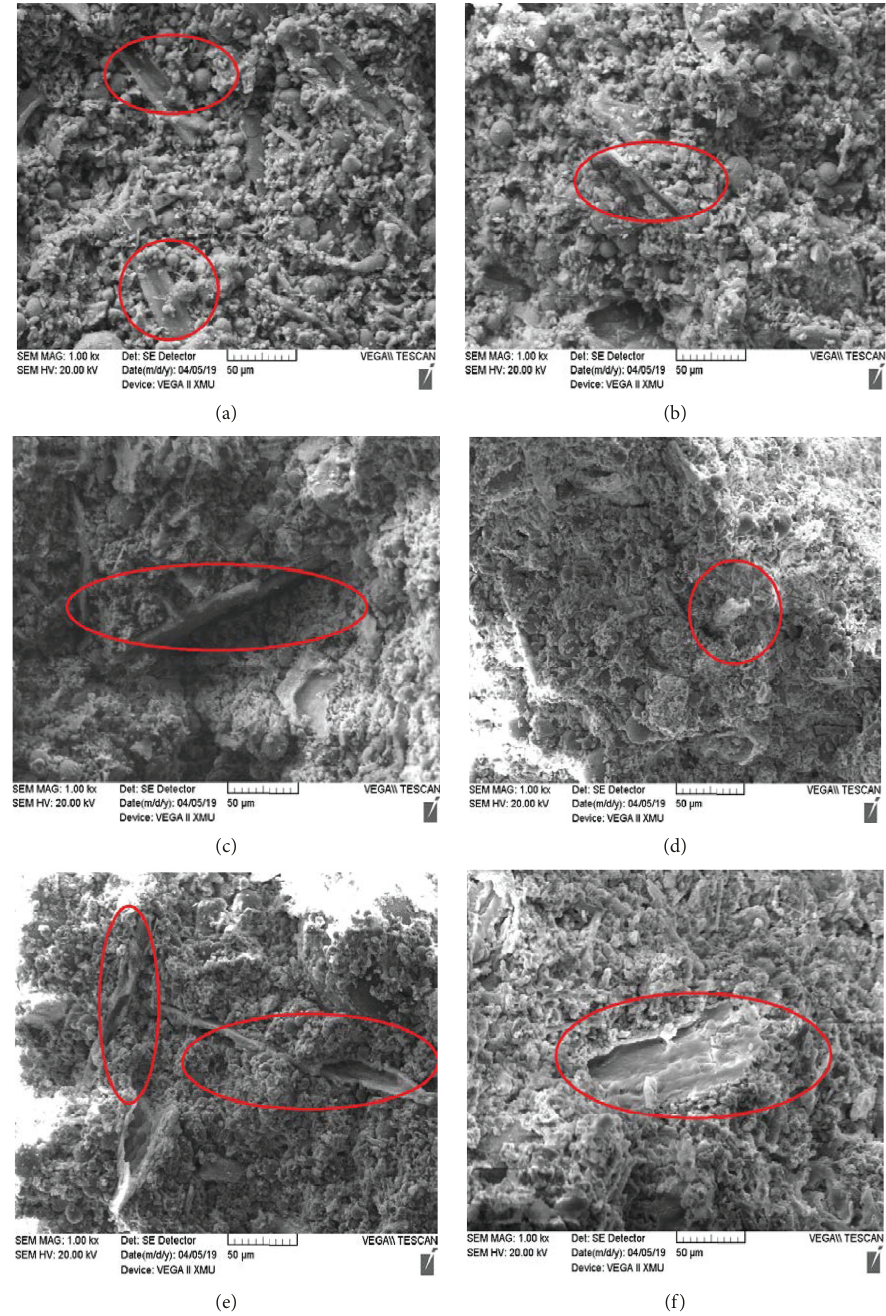
Figure 8: Microscopic images of C10F30 before and after exposure to different temperatures (CaCO (a) 20 ° C, (b) 200 ° C, (c) 400 ° C, (d) 600 ° C, (e) 800 ° C, and (f) 1000 °